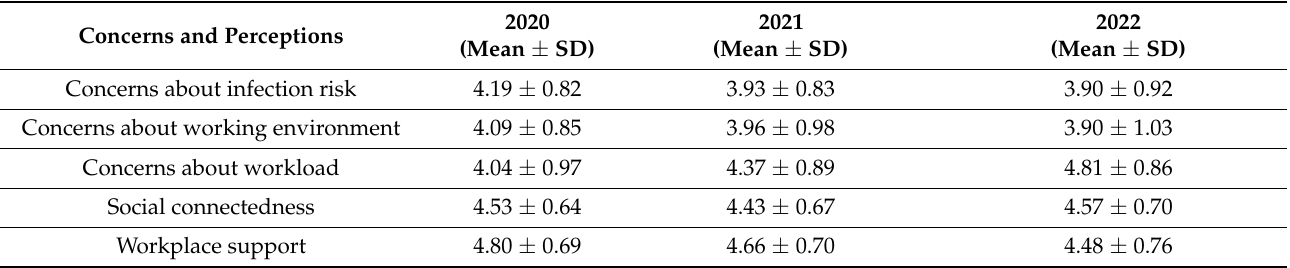
Table 2. The mean scores for the different categories of ED HCWs’ concerns and perceptions for the three cohorts. Comparison of mean scores of ED HCWs’ concerns and perceptions within the subgroups for the three